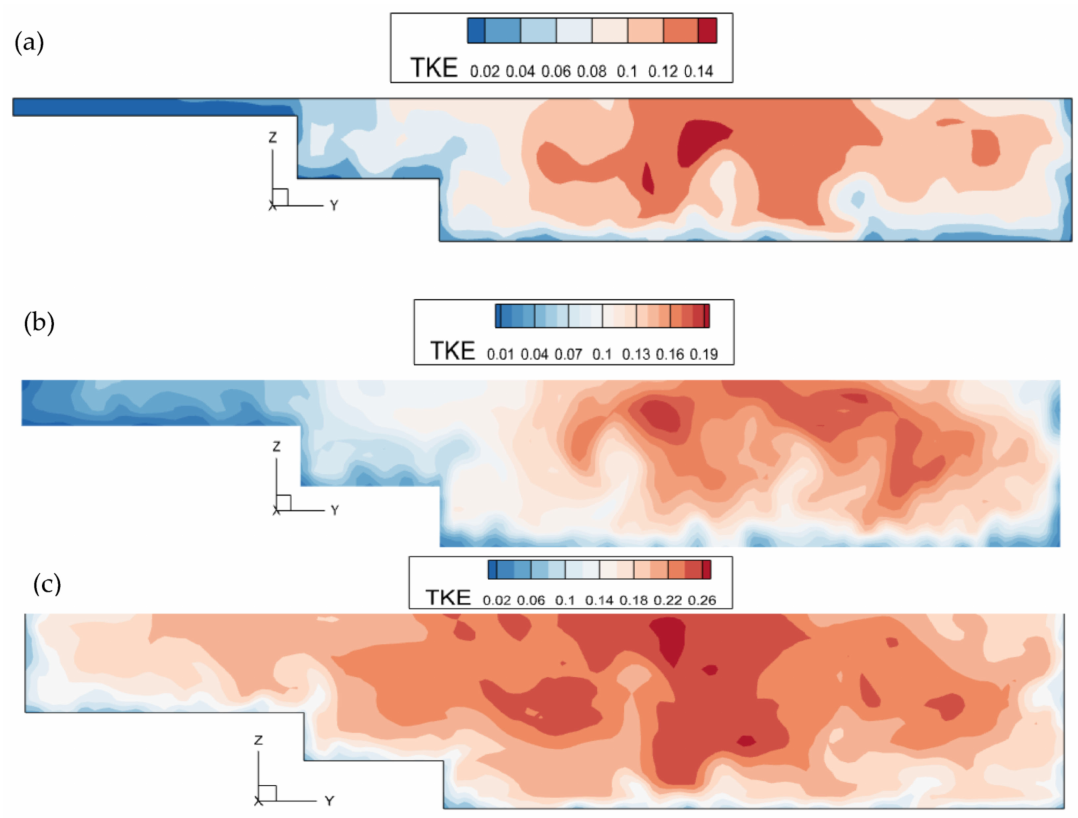
Figure 5. Contour mapping of the turbulent kinetic energy in m 2 /s 2 for ( a ) Dr = 0.1, ( b ) Dr = 0.3 and ( c ) Dr =